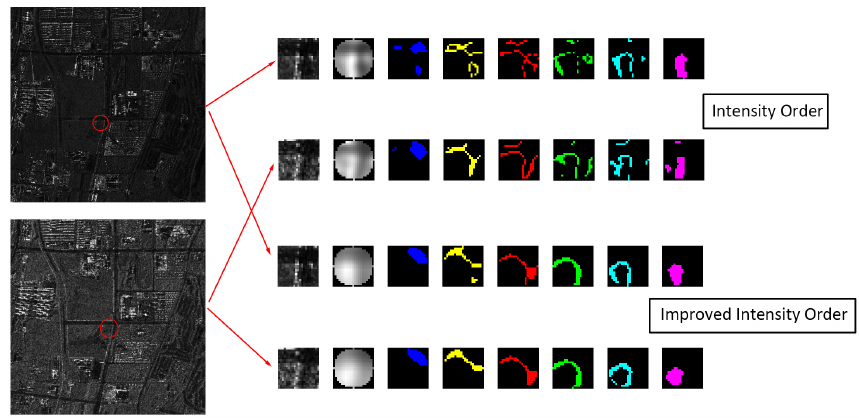
Figure 3. Division results based on the intensity order and the improved intensity